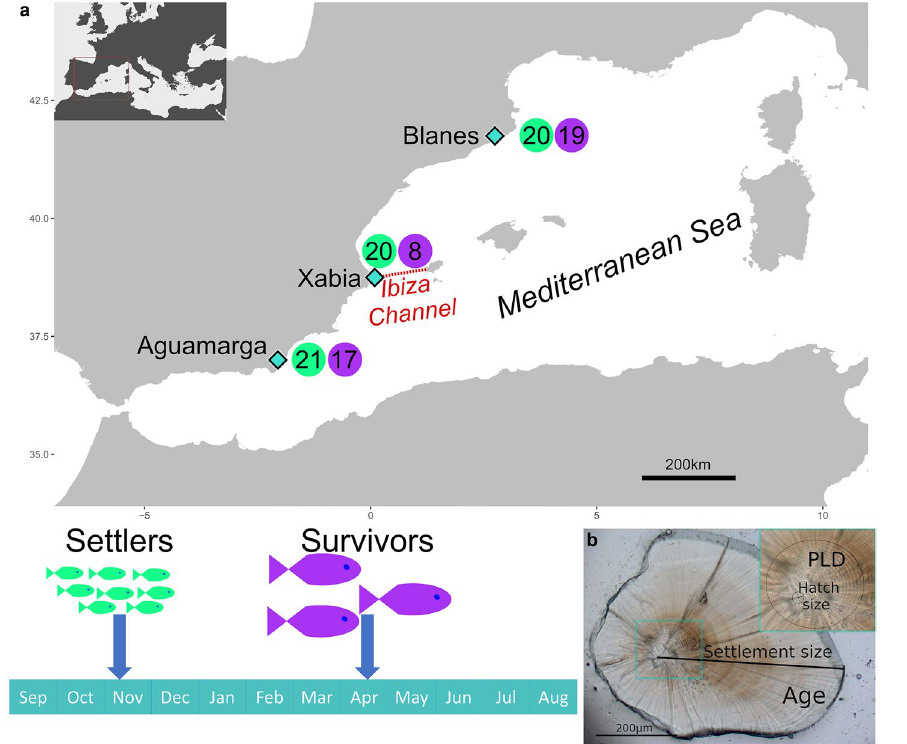
Figure 1. Sampling sites and experimental design to test for selective mortality in Diplodus puntazzo . ( a ) Location of the three sites (Blanes, Xabia and Aguamarga) where recently settled individuals (in green) were collected in November 2015 (Settlers) and individuals surviving winter (in purple) were collected in April 2016 (Survivors). The number of individuals analysed in each age group and site are given in the circles. Map was made using R ggplot2 package 53 . ( b ) The otolith of each individual was used to obtain individual hatch, larval and settlement phenotypic variables (hatch date, hatch size, settlement date and settlement size, pelagic larval duration (PLD) and pelagic larval growth rate) and environmental variables (moon phase at hatching and settlement, and temperature during pelagic larval